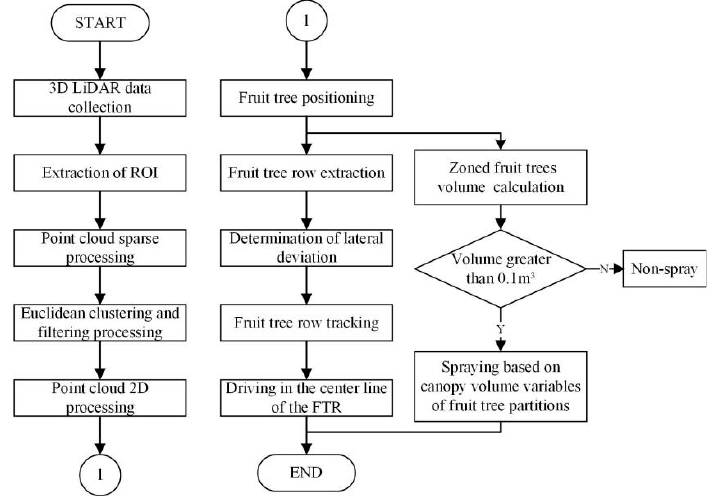
Figure 4. Workflow.